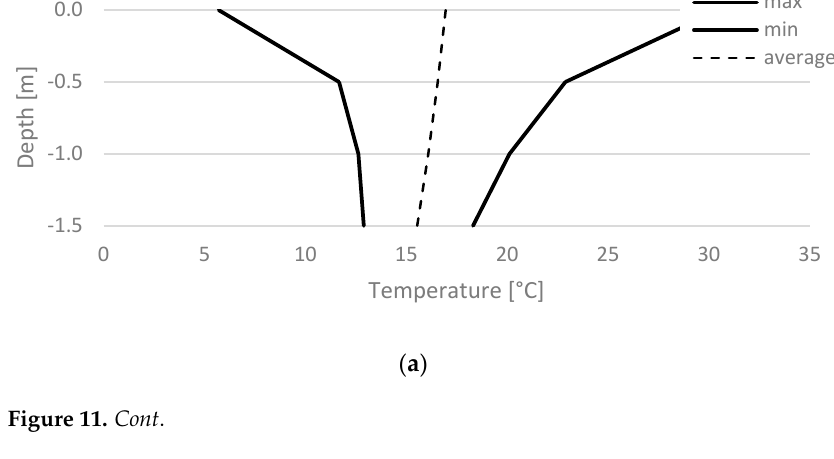
Figure 10. Temperature of the floor and soil in variant 1.